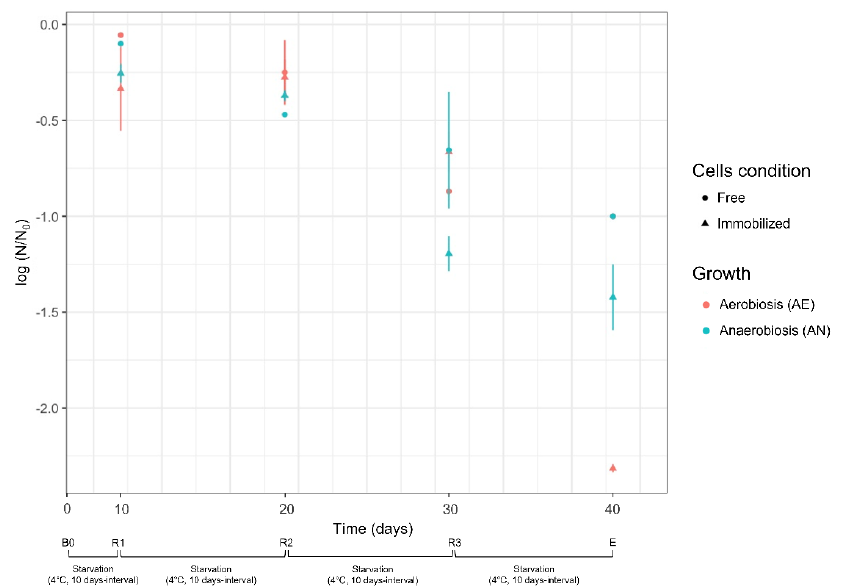
Figure 2. GABA produced (mol/L) and extruded by cells (panel A ) and fraction of glutamate (expressed as a ratio between initial GLU and GLU transported into the cells) available for bioconversion (panel B ). Cell condition (free, immobilized) and growth (aerobiosis, anaerobiosis) used for biocatalysis are described in sections 2.4.1 and 2.4.2. Bioconversion and recycling steps: B0, first bioconversion step (time: 0 days) carried out with fresh cells; R1, R2, and R3: recycling steps carried-out at 10 day interval (up to 30 days) with resting cells (see Section 2.4.3); E, end of starvation and bioconversion steps.